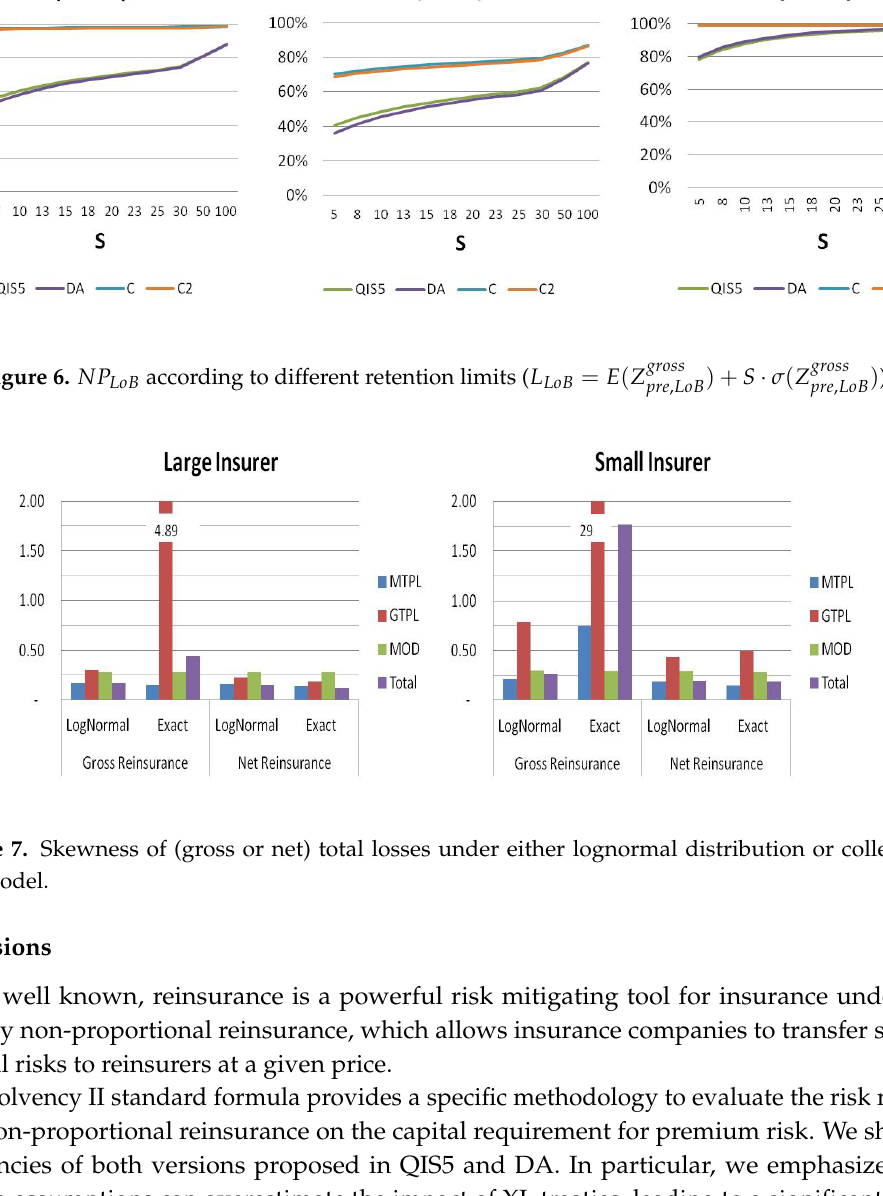
Figure 7. Skewness of (gross or net) total losses under either lognormal distribution or collective risk